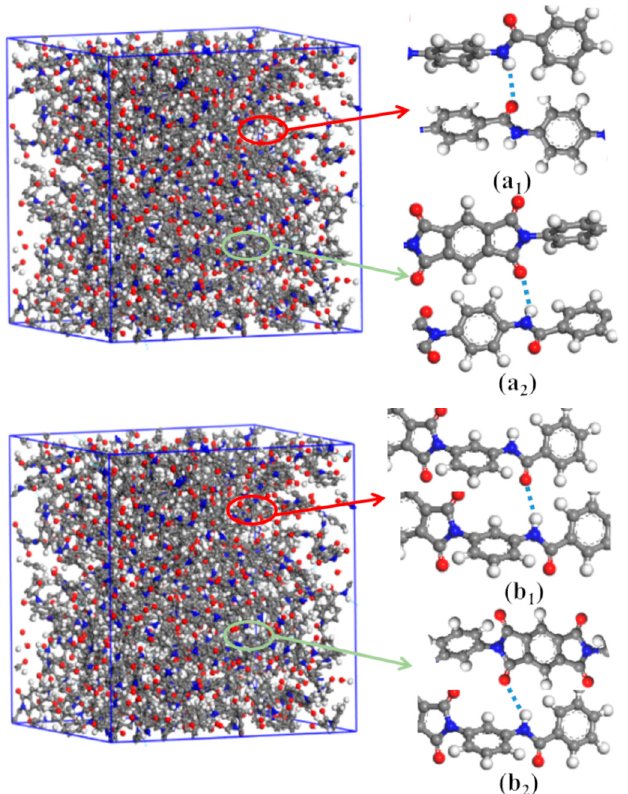
Figure 5. H-bonds in the simulation cell of DABPI ( a 1 , a 2 ) and m-DABPI ( b 1 , b 2 ). H-bonds between ‒ HN ‒ and O = C ‒ in amide groups ( a 1 , b 1 ) and between ‒ HN ‒ and O = C ‒ in imide rings ( a 2 , b 2 ).